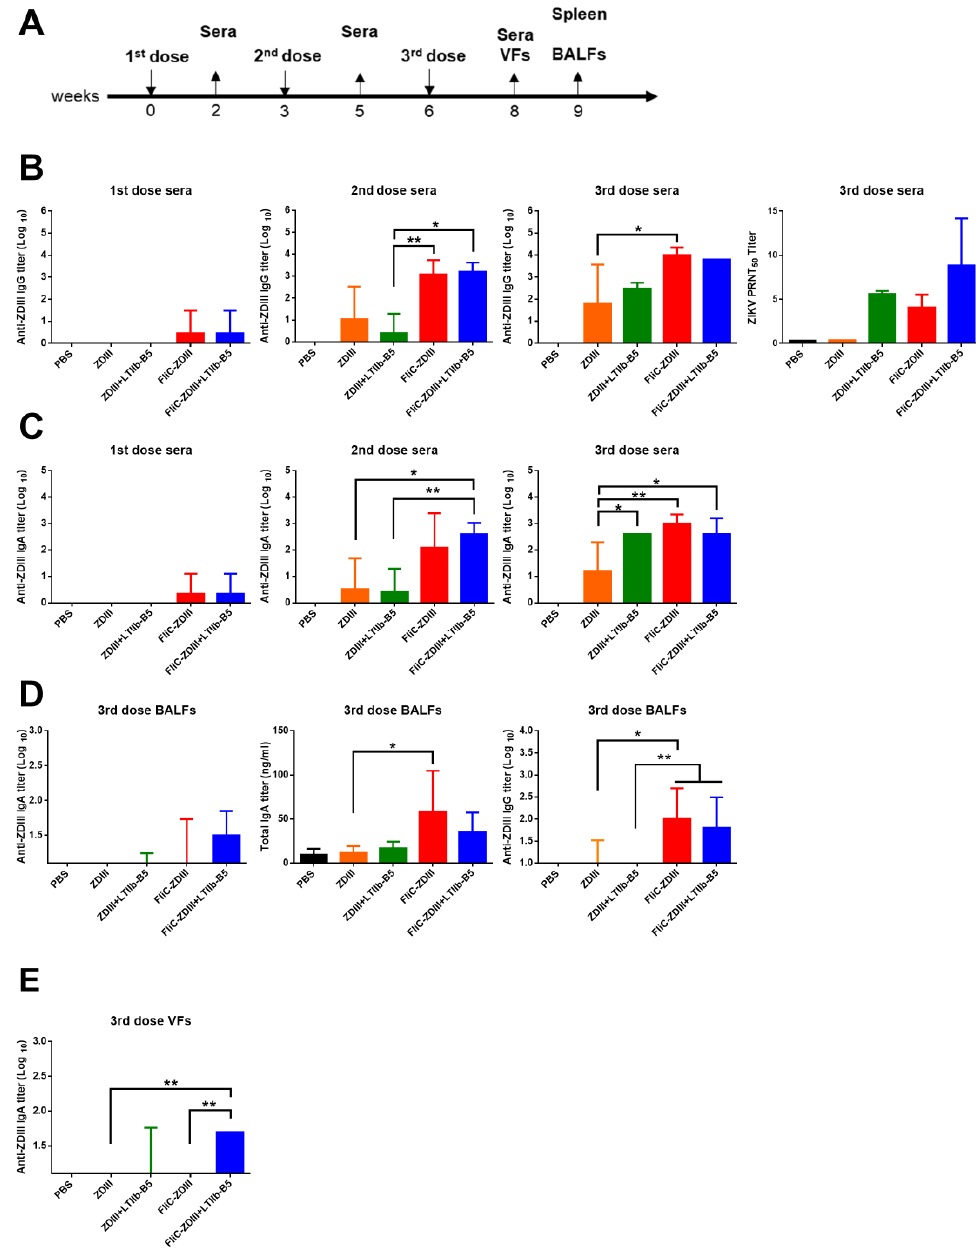
Figure 2. Immunization with ZDIII and FliC-ZDIII proteins and antibody responses in sera, BALFs, and VFs. ( A ) Illustration of immunization regimens. Five groups of BALB/c mice (n = 5 per group) of PBS, 5 µ g ZDIII, 20 µ g ZDIII + 1 µ g LTIIb-B5, 20 µ g FliC-ZDIII, and 20 µ g FliC-ZDIII + 1 µ g LTIIb-B5 were immunized three doses via the intranasal route. Sera were collected two weeks after each dose immunization. VFs were collected two weeks after the 3rd dose immunization. The spleen and BALFs were collected three weeks after the 3rd dose immunization; ( B ) ZDIII-specific IgG titers in 1st dose, 2nd dose, and 3rd dose sera; and the ZIKV neutralizing antibody titers (PRNT-50) in 3rd dose sera; ( C ) ZDIII-specific IgA titers in 1st dose, 2nd dose, and 3rd dose sera; ( D ) ZDIII-specific total IgA titers, the overall total IgA titers, and ZDIII-specific total IgG titers in BALFs after the 3rd dose immunization; ( E ) ZDIII-specific total IgA titers in VFs after the 3rd dose. Statistical test for multiple comparison for all groups except PBS were analyzed using one-way ANOVA with Tukey’s or Holm-Sidak’s multiple comparison tests. (*, p < 0.05 and **, p < 0.01). Error bars are plotted as standard deviation from the mean value.